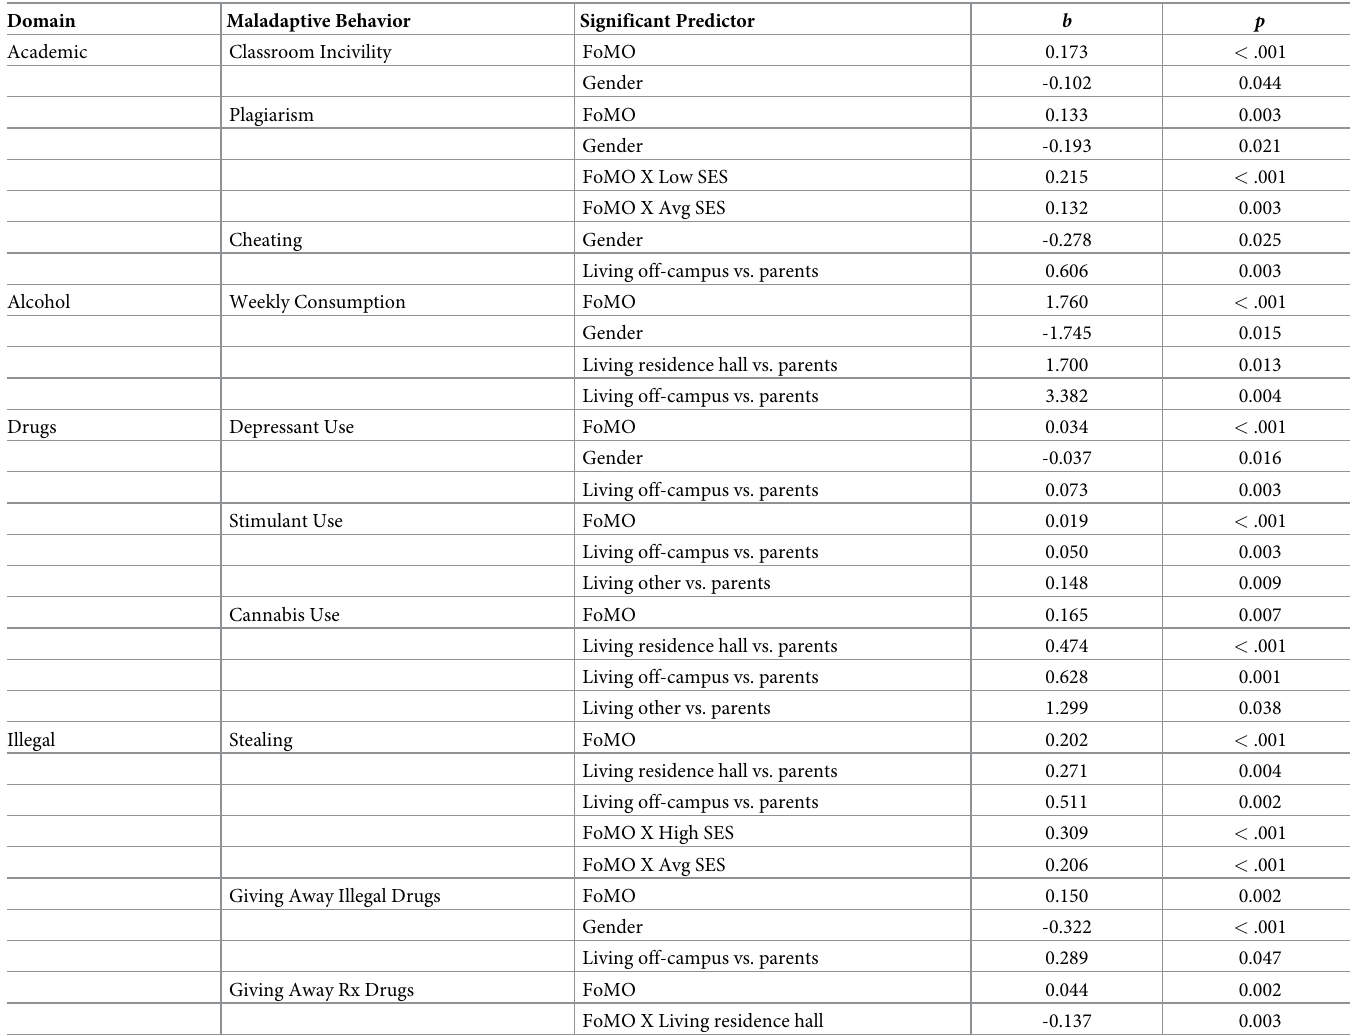
Table 2. Summary of significant relationships from hierarchical regression modeling.